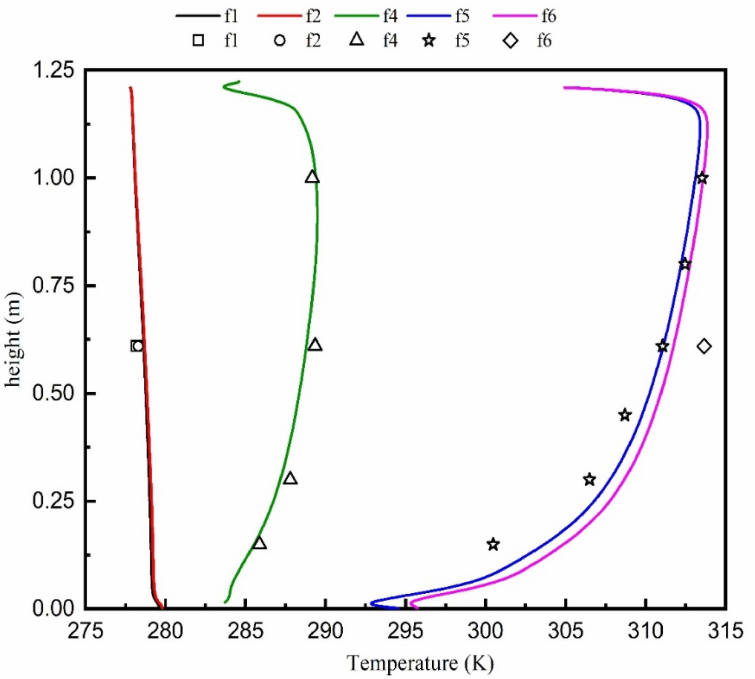
Figure 19. Experimental and numerical temperature profiles for the three glazings, according to k-w models, P = 475 W.m − 2 .